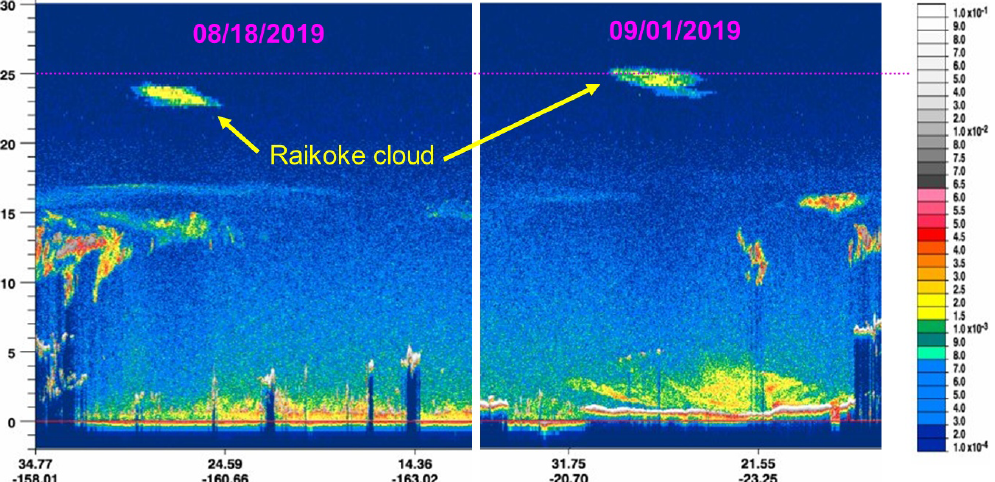
Figure 16. The CALIOP total attenuated backscatter data (km − 1 sr − 1 ) for 18 August and 1 September 2019, where the CCC is visible at the indicated latitudes and heights.